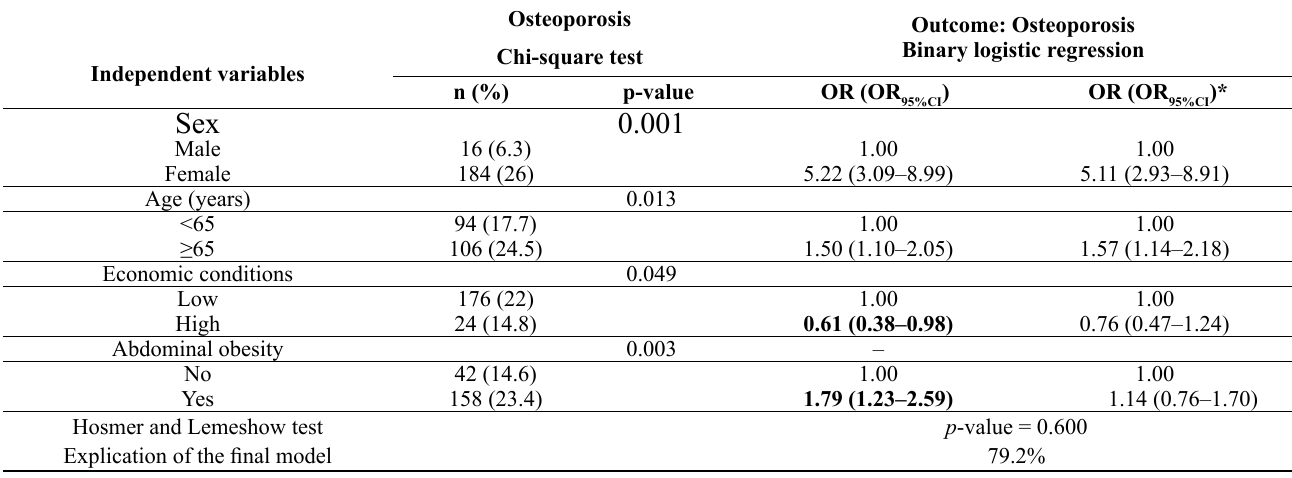
Table 1 . Associations between osteoporosis and some independent variables among Brazilian adults (n = 963).